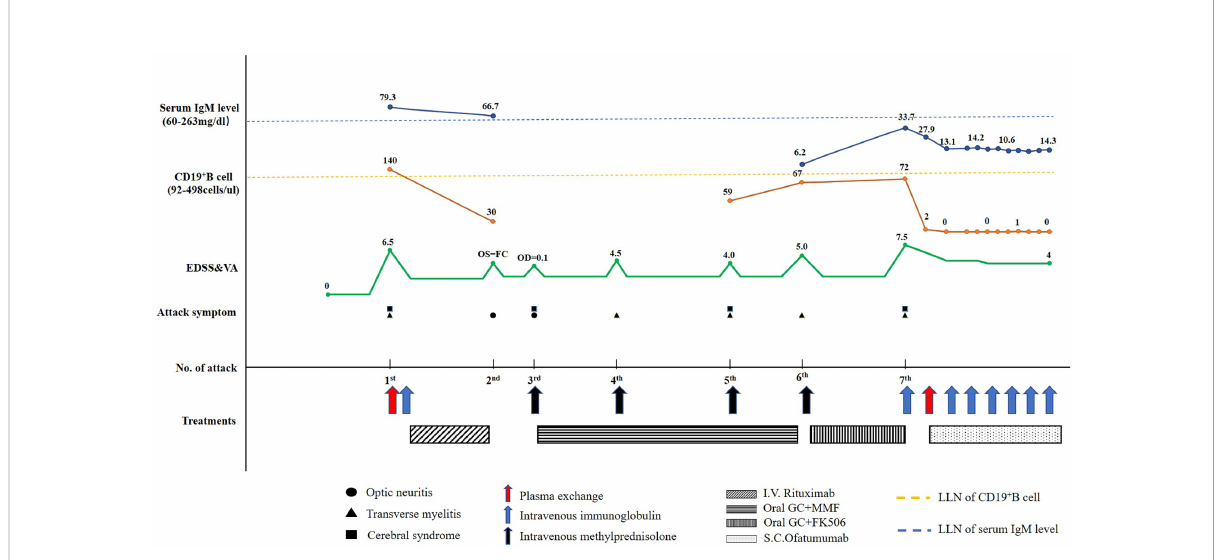
FIGURE 2 Schematic illustration of the disease course showing the temporal sequence of symptoms, disability, treatment details, CD19 + B cell count, and serum IgM level. EDSS, Expanded Disability Status Scale; FC, fi nger count; FK506, tacrolimus; GC, glucocorticoids; I.V., intravenous; S.C., subcutaneous; MMF, mycophenolate mofetil; OD, right visual acuity; OS, left visual acuity; LLN, lower limits of normal; VA, visual